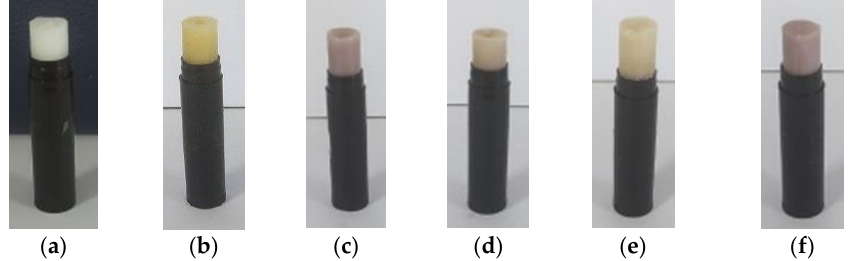
Figure 3. Spice stick balsams made from lemon pepper (LP) and black ginger (BG) macroemulsions.